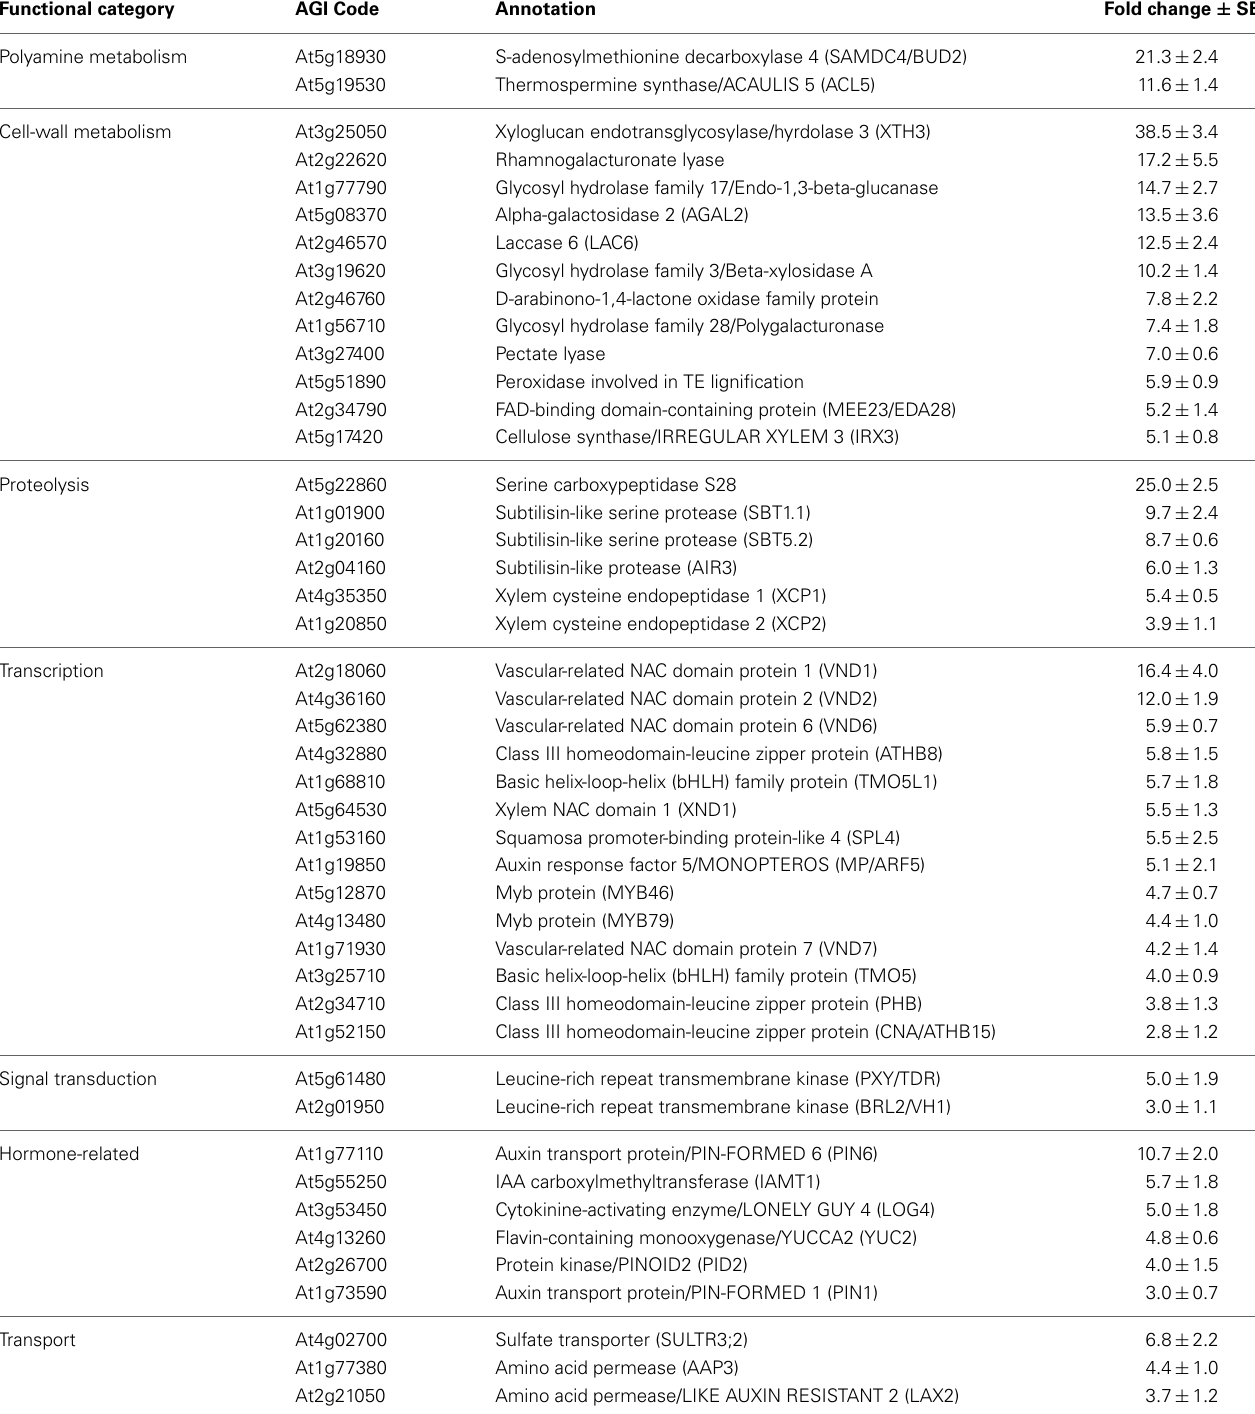
Table 3 | List of representative genes up-regulated in acl5-1 seedlings. Functional